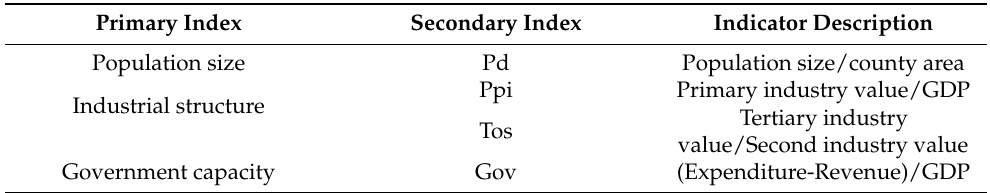
Table 1. Index selection of influencing factors of county comprehensive